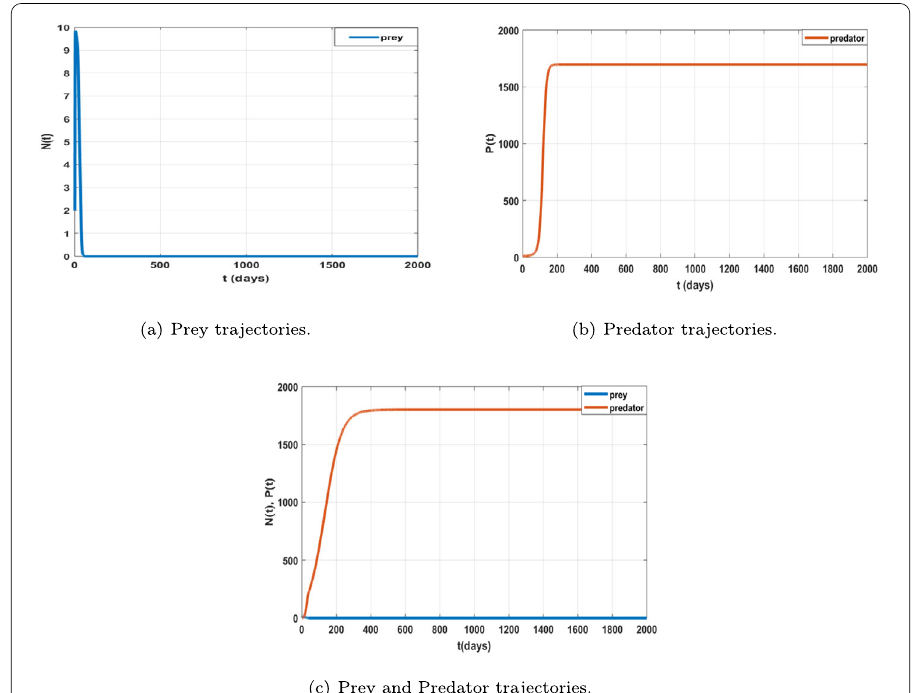
Figure 2 Evolution of system (2.3) around E 1 = (0,1800)